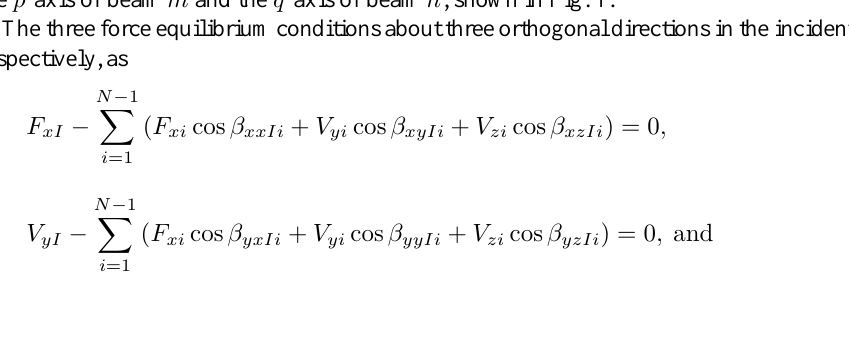
Fig. 5. The power transmission and reflection coefficients of two semi-infinite Euler-Bernoulli beams with the same material and geometrical properties joined at 45 ◦ : (a) Case of the incident flexural wave, (b) Case of the incident longitudinal wave. respectively. The sign convention of the moments in each beam is shown in Fig. 2. β pqmn denotes the angle between the p -axis of beam m and the q -axis of beam n , shown in Fig.